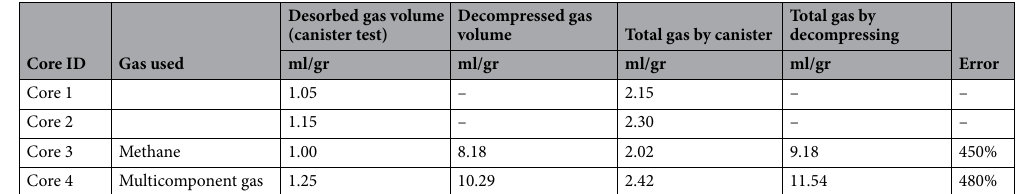
Table 3. Gas in place measurements by high pressure charging (decompressed) and standard canister methods. The gas volumes are normalized by weight of shale rock samples. The error presented in the last column is the difference between decompressed and canister volumes divided by the decompressed gas volume.